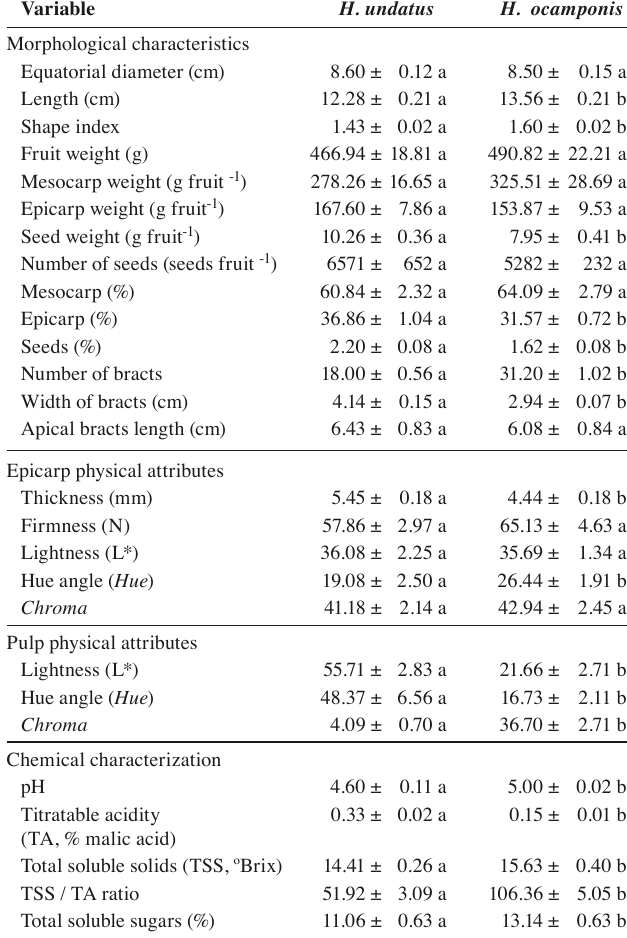
Tab. 1: Physical and chemical characterization of pitahaya fruits with white ( Hylocereus undatus ) and red pulp ( H. ocamponis ).